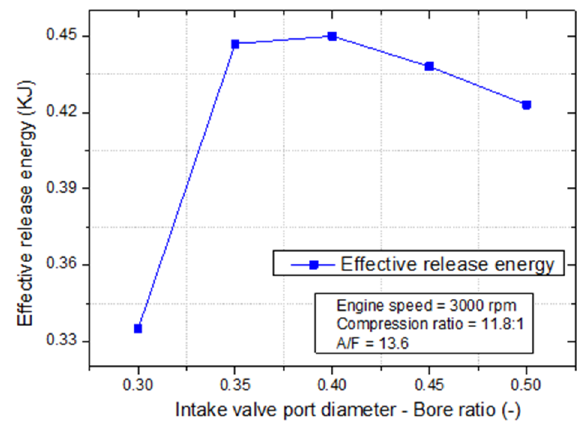
Figure 8. ERE versus IPD/B.